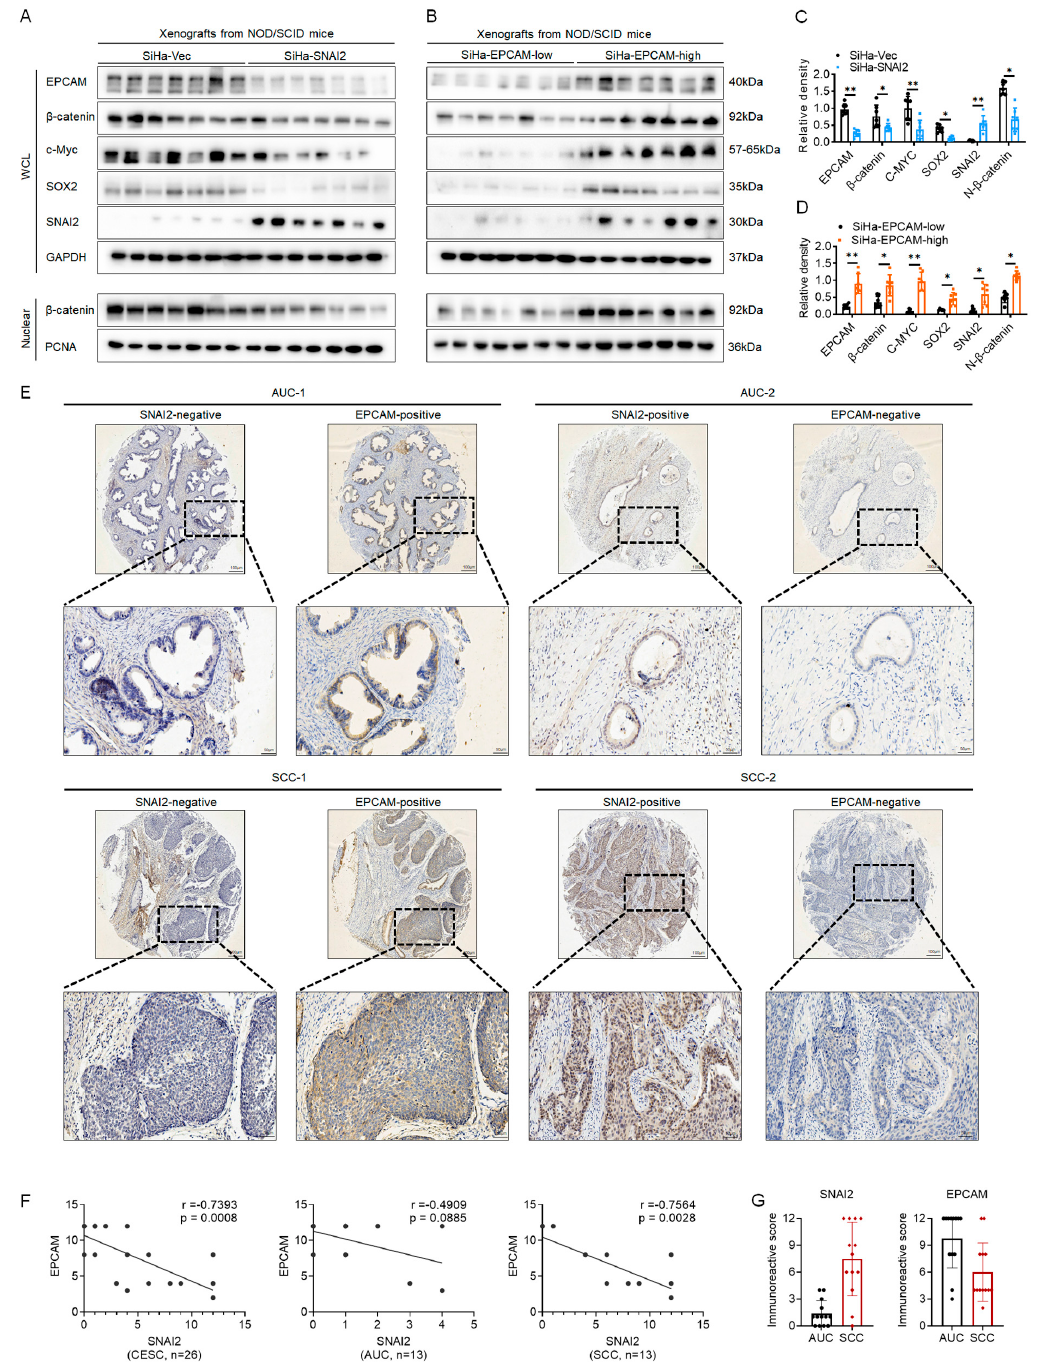
Figure 5. The negative correlation of the protein level of SNAI2 and EPCAM in tissue samples. The protein levels of EPCAM, β -catenin, c-Myc, SOX2, SNAI2, and nuclear β -catenin in SiHa-SNAI2- and SiHa-Vec-cells derived mouse xenografts ( A , C ) or in SiHa-EPCAM high - and SiHa- EPCAM low - cells-derived mouse xenografts ( B , D ) were detected by Western blotting. ( E ). The protein levels of SNAI2 and EPCAM in human tissue were detected via using the TMA (tissue microarray) approach, and the representative photos are shown. Scale bars, 400 × and 1000 × . ( F ). The Pearson correlation analysis was performed to analyze the correlation between SNAI2 and EPCAM in CESC (n = 26), adenocarcinoma of the uterine cervix specimens (AUC, n = 13), and squamous carcinoma of the cervix specimens (SCC, n = 13) samples. ( G ). The immunoreactive score (IRS) of SNAI2 and EPCAM in AUC and SCC specimens. * p < 0.05, ** p < 0.01, vs.